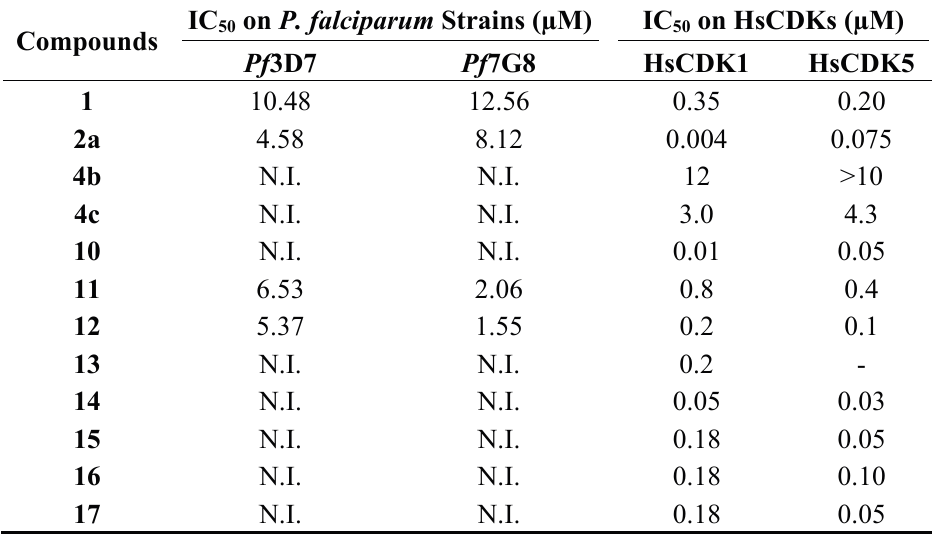
Table A1. IC 50 values of the screened compounds on HsCDKs, and comparison with the Plasmodium faciparum 3D7 and 7G8 strains growth inhibition. Purines were tested at various concentrations as described in experimental section. IC 50 values are reported in µM. On mammalian kinases, IC 50 were estimated from dose-response curves and are expressed in µM. All assays were run in triplicates and data points were within less than a 10% range. -, not tested. IC 50 value reported as >10 means that less than 50% inhibition at 10 µM was observed; N.I. (Not Inhibitor) indicates that the compound did not display any inhibitory activity. On Pf strains, IC 50 were estimated by non-linear regression analysis using an inhibitory sigmoid E max model. All assays were run in